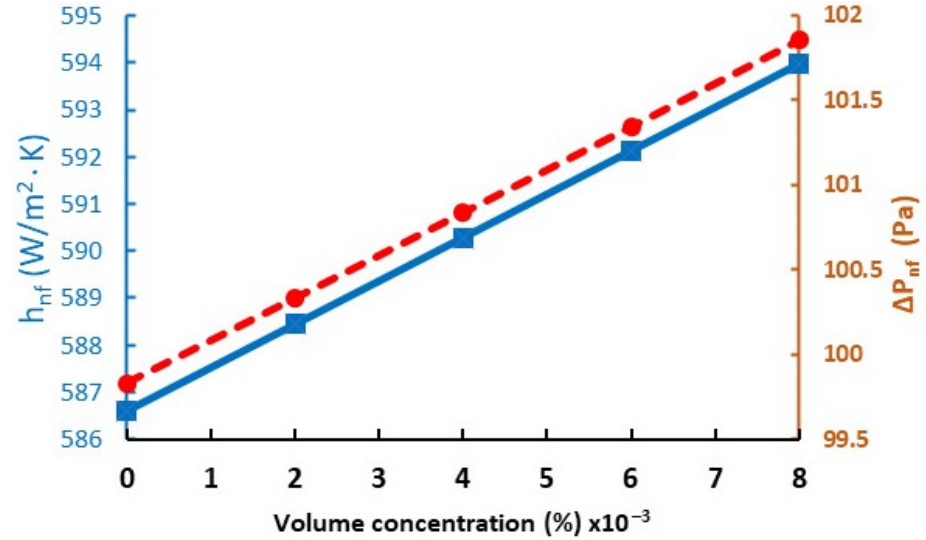
Figure 12. Heat transfer coefficient and pressure drop versus concentration variation (blue solid line represents heat transfer coefficient and red dash-dotted line represents pressure drop).